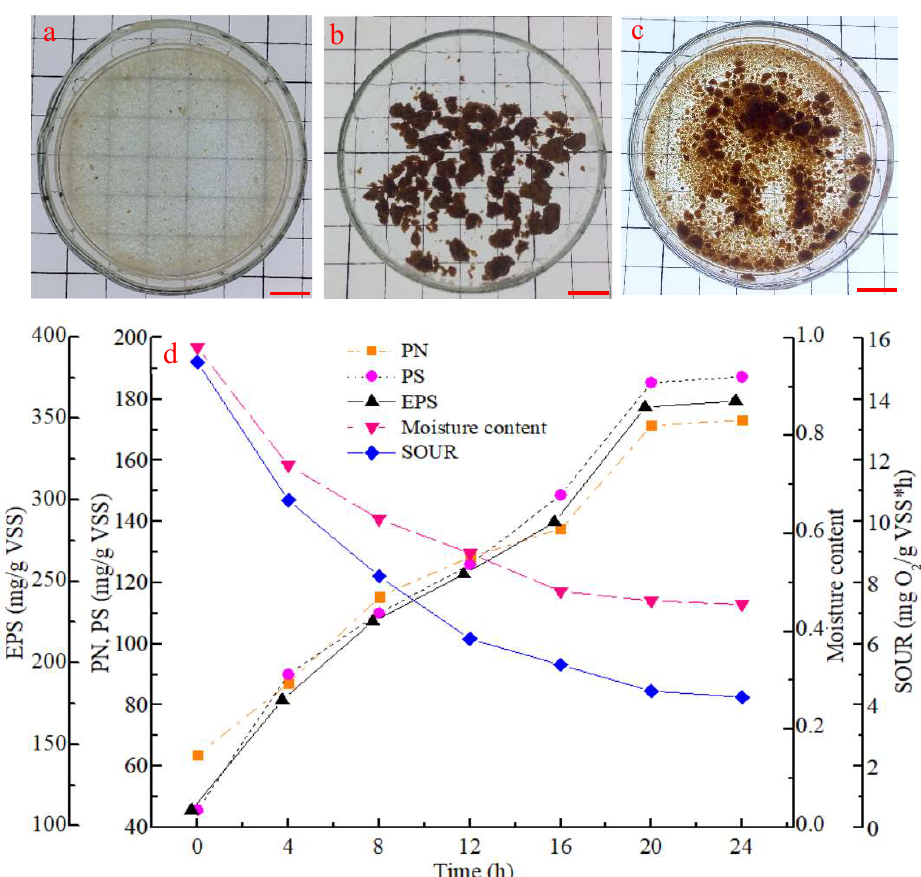
Figure 1. Evolution of sludge physicochemical properties throughout the external conditioning process with FeCl 3 : ( a ) raw effluent sludge, ( b ) sludge after 24 h of external conditioning with FeCl 3 and air-drying, ( c ) sludge manually crushed in fresh water, and ( d ) variations in PN, PS, EPS, SOUR and moisture content throughout the conditioning process. Scale: 1 cm.